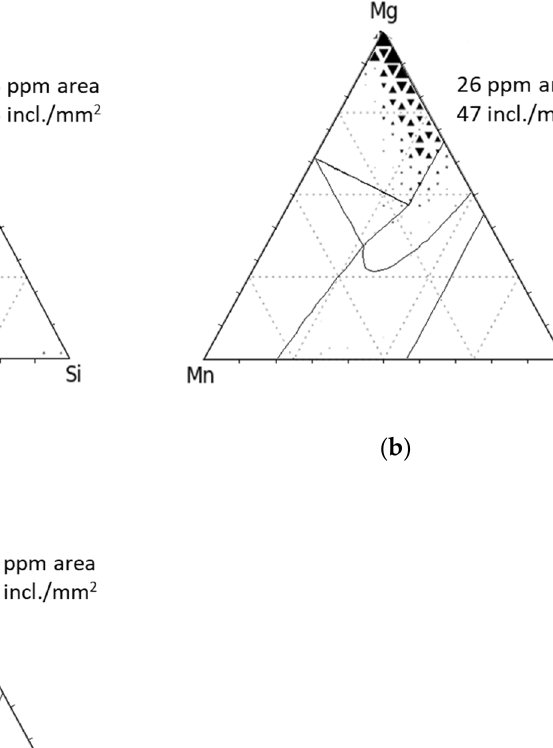
Figure 3. Ternary diagrams showing nonmetallic inclusion evolution during a steel–slag reaction. Inclusion compositions (as analyzed by SEM/EDS) are plotted as mole fractions of MnO, SiO 2 , and MgO. Each ternary represents a sample taken at different times: ( a ) immediately before slag addition, and ( b ) 800 s, ( c ) 1,580 s, ( d ) 3,080 s, and ( e ) 4,540 s after slag addition. The triangles are proportional to the area fraction of that nonmetallic inclusion composition. Ternary ( f ) is the